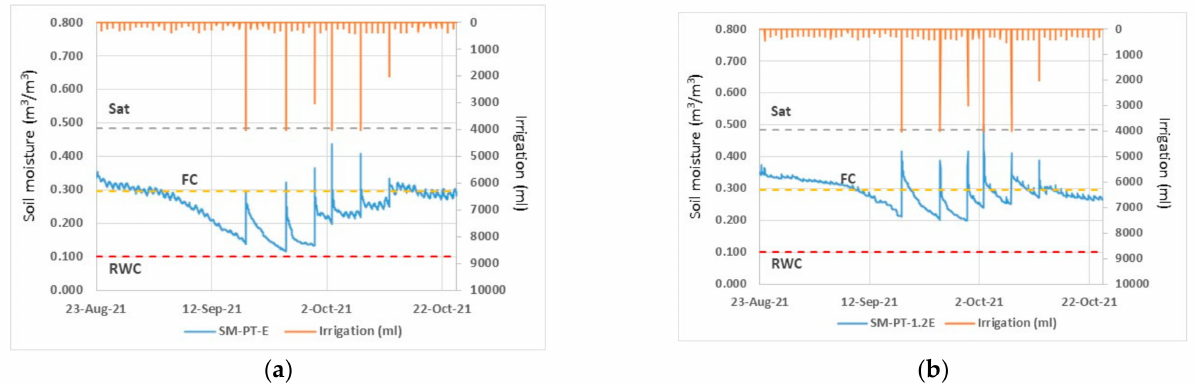
Figure 8. The fluctuation in soil moisture and irrigation: ( a ) PT-E treatment, ( b ) PT-1.2E treatment. Note: Sat: saturated water content, FC: field capacity water content, RWC: residual water content.